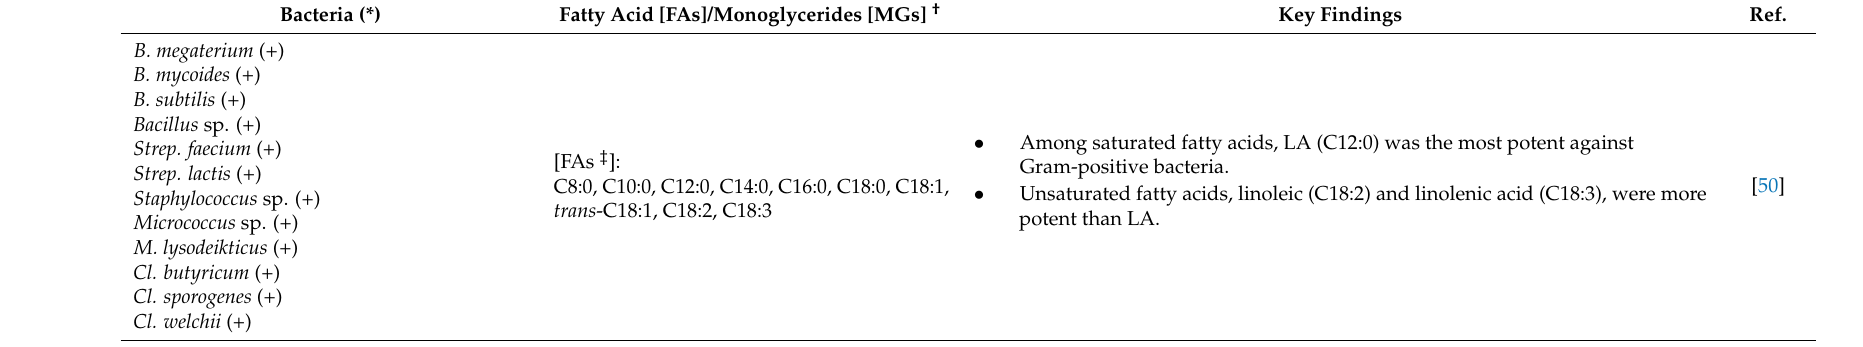
Table 1. Antibacterial activity of fatty acids and monoglycerides against different bacteria.